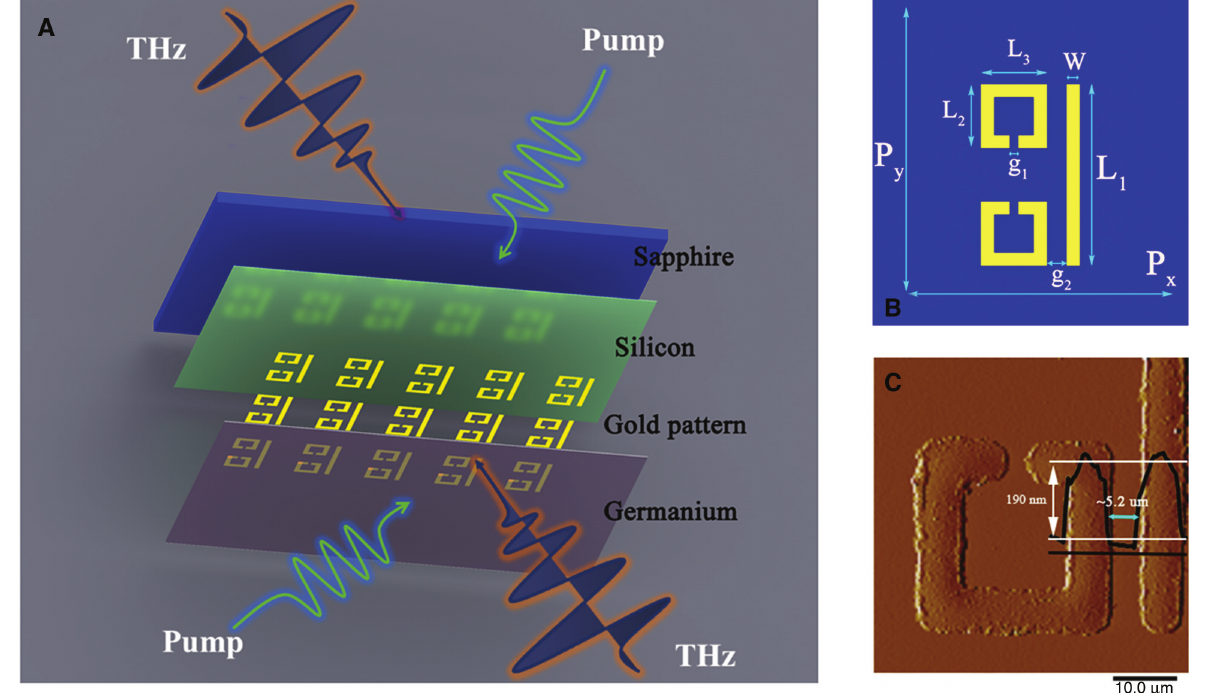
Figure 1: Characterization and schematic diagram of the modulation-speed controllable THz device. (A) Principle schematic diagram of the proposed metamaterial integrated with a layer of Si (500 nm) and Ge film (600 nm) on the lower and upper surfaces of the gold resonators, whose response speed is tunable. The Si and Ge films can be excited by forward and backward = 85 optical pump pulses as a photoactive layer. (B) Schematic view of the functional unit cell. The geometrical parameters are as follows: L 1 μ m, L = L = 30 μ m, W = 6 μ m, g = 4 μ m, g = 5 μ m. The period is P = 80 μ m, P = 120 μ m. The height of the Au pattern is 190 nm. (C) Atomic 2 3 1 2 x y force microscope (AFM) image of one corner of a unit cell. Inset: the AFM line scan corresponding to the gap of g . Scale bar, 10 μ 2